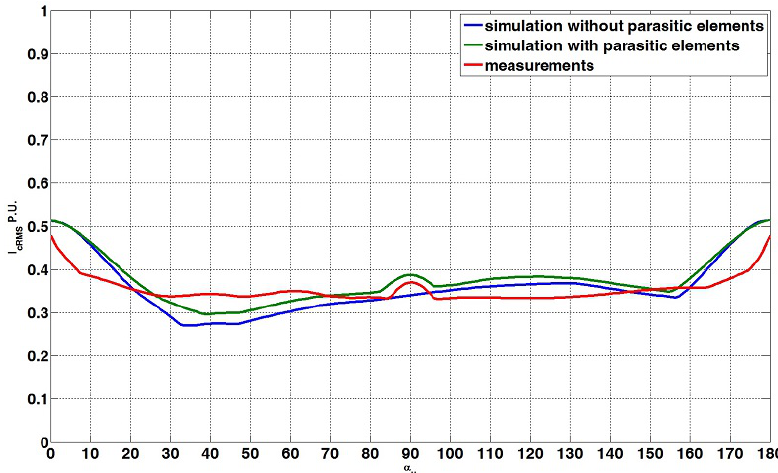
Figure 19. I C worst case for α u variation for considered couples of M and V-I phases values. The rms blue line is the simulated I C for triple-3-phase converter in Figure 4, the green line is the simulated rms I C considering a model of the triple-3-phase converter used in the laboratory setup with estimated rms concentrated resonance parameters, and the red line is the measured evolution of I C laboratory